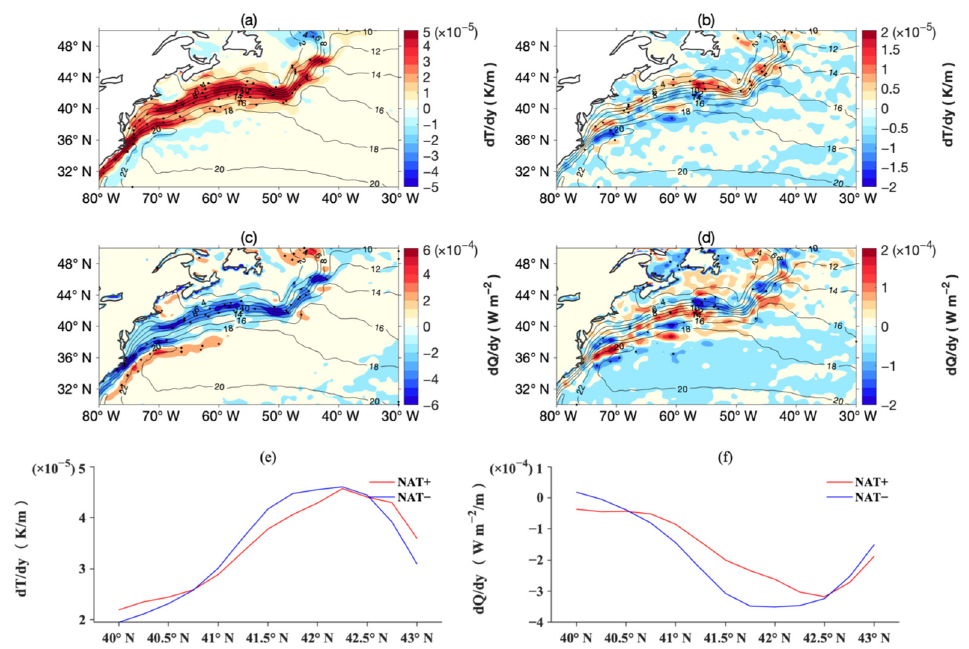
Figure 2. ( a ) Colors are SST gradients (dT/dy) in NAT+ phase (K/m). Contours are mean SSTs in NAT+ phase ( ◦ C). ( b ) Difference in dT/dy between NAT+ and NAT − phases. Contours are mean SSTs in NAT − phase. ( c ) Air—sea sensible heat flux gradient (dQ/dy) in NAT+ phase (W m − 2 ). Contours are the same as in ( a ). ( d ) Difference in dQ/dy between NAT+ and NAT − . Contours are the same as in ( b ). ( e ) Meridional distribution of dT/dy averaged between 55 ◦ W and 65 ◦ W. ( f ) Same as ( e ) but for dQ/dy.